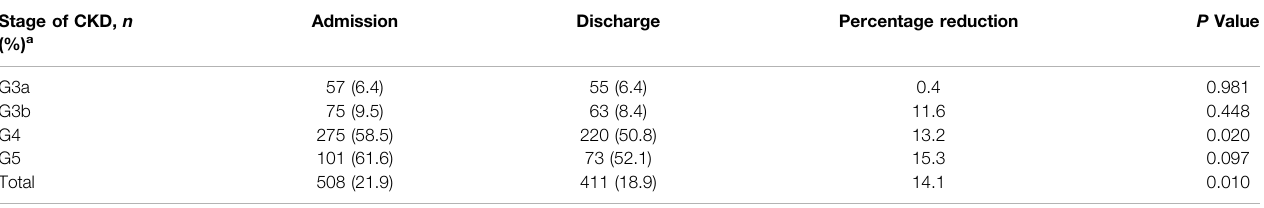
TABLE 2 | Inappropriate drug use at admission and discharge in patients with eGFR < 60 ml/min/1.73 m 2 . Stage of CKD, n (%) a